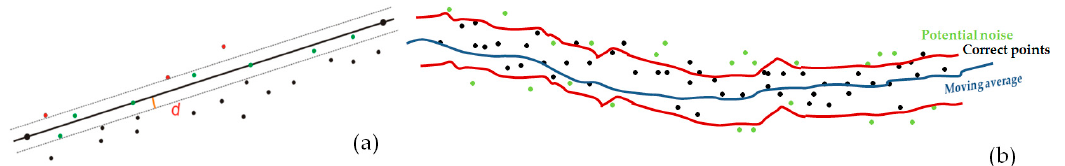
Figure 7. Schematic results of filtering algorithms: ( a ) Algorithm 1, ( b ) Algorithm 2.